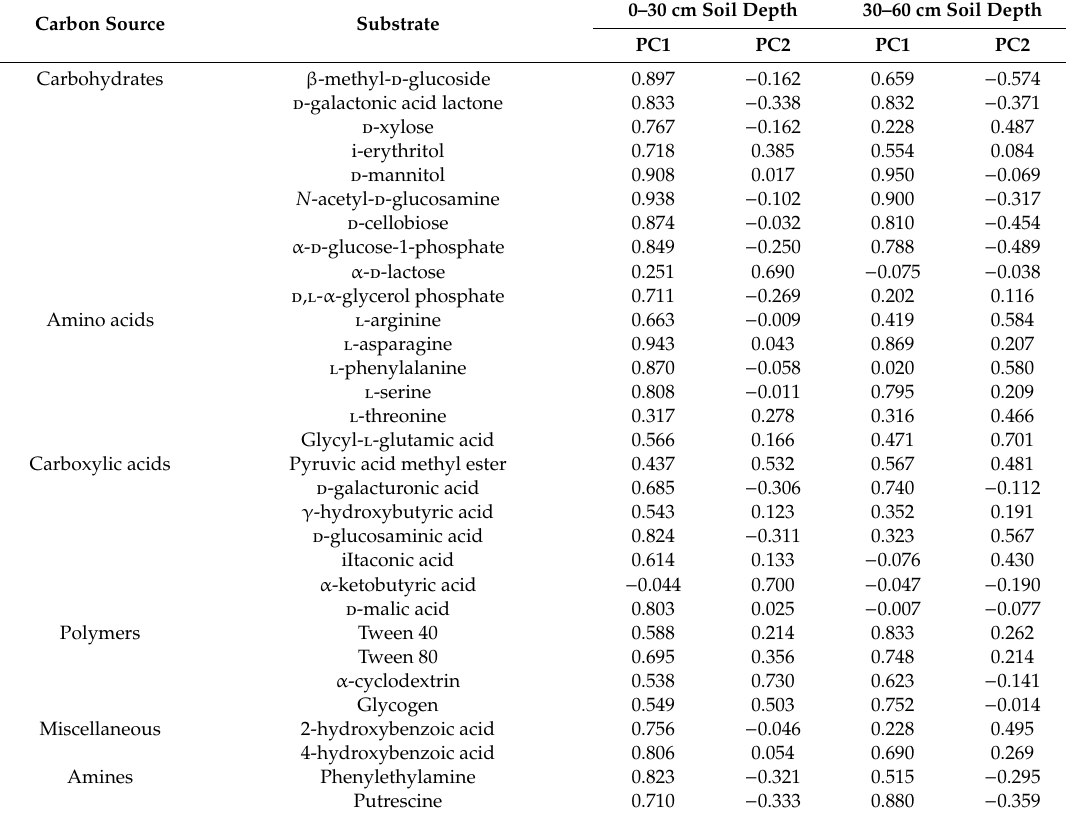
Table 3. Correlation analysis of carbon source utilization using the Biolog EcoPlates, versus the loading values of PC1 and